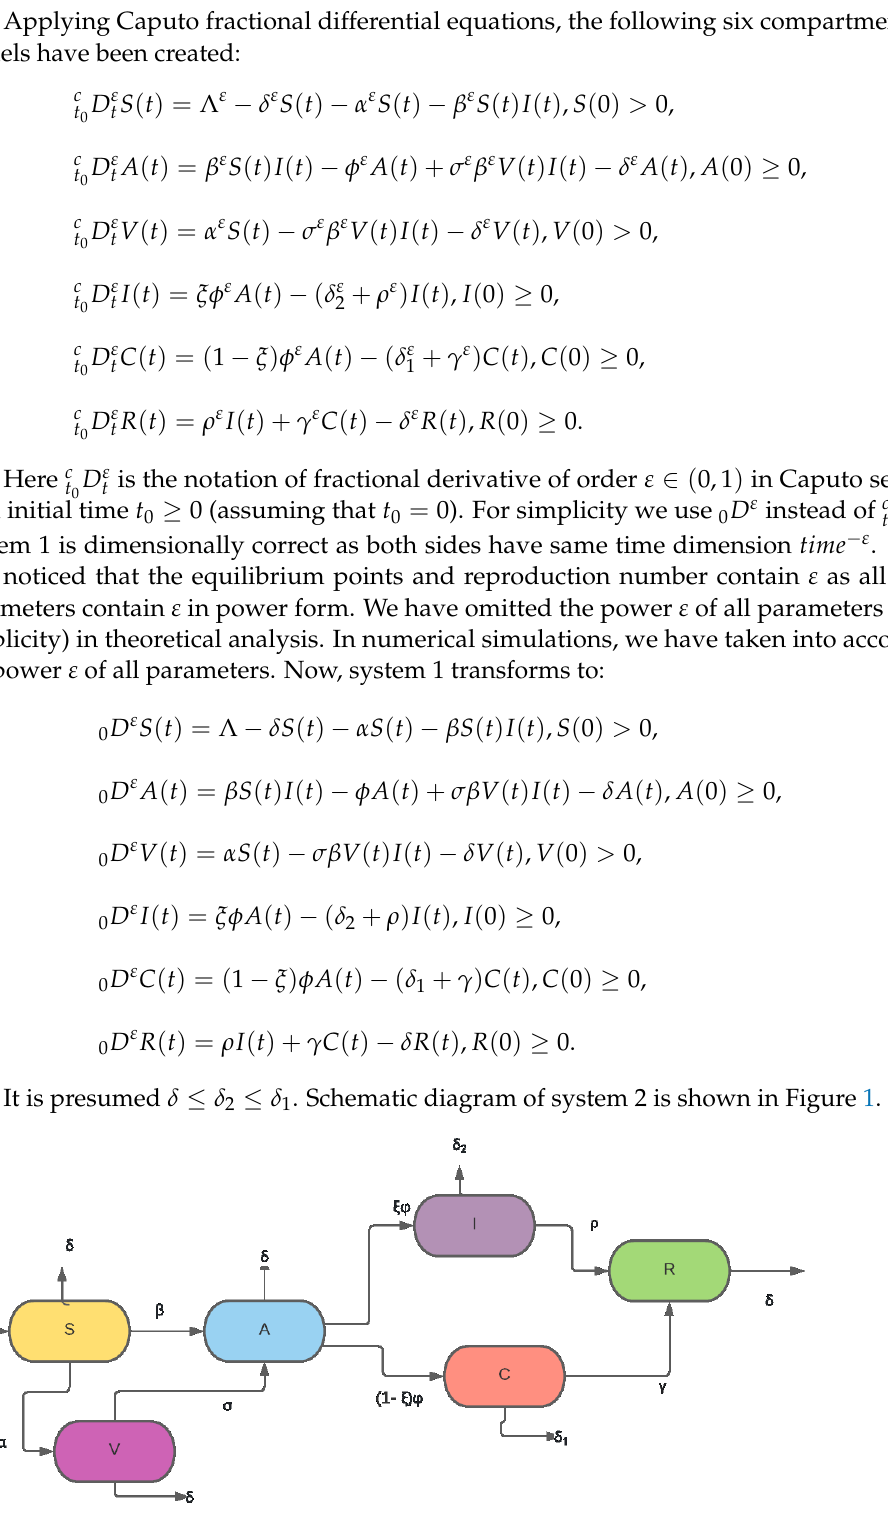
Figure 1. The system 2 is represented schematically. The susceptible, asymptomatically infected, Vaccinated class, symptomatically in- fected without co-morbidity, symptomatically infected with co-morbidity and recovered or removed population at time t are represented by S ( t ) , A ( t ) , V ( t ) , I ( t ) , C ( t ) , and R ( t ) , respectively. Table 1 provides a brief description of all